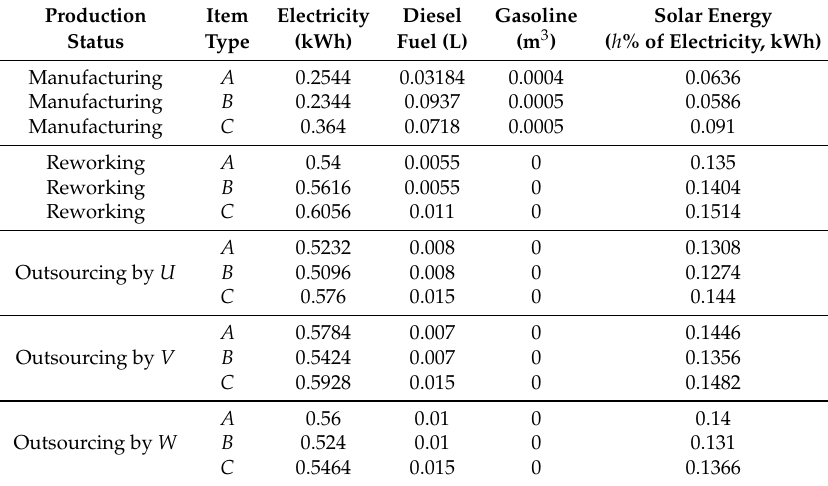
Table 7. Energy consumption